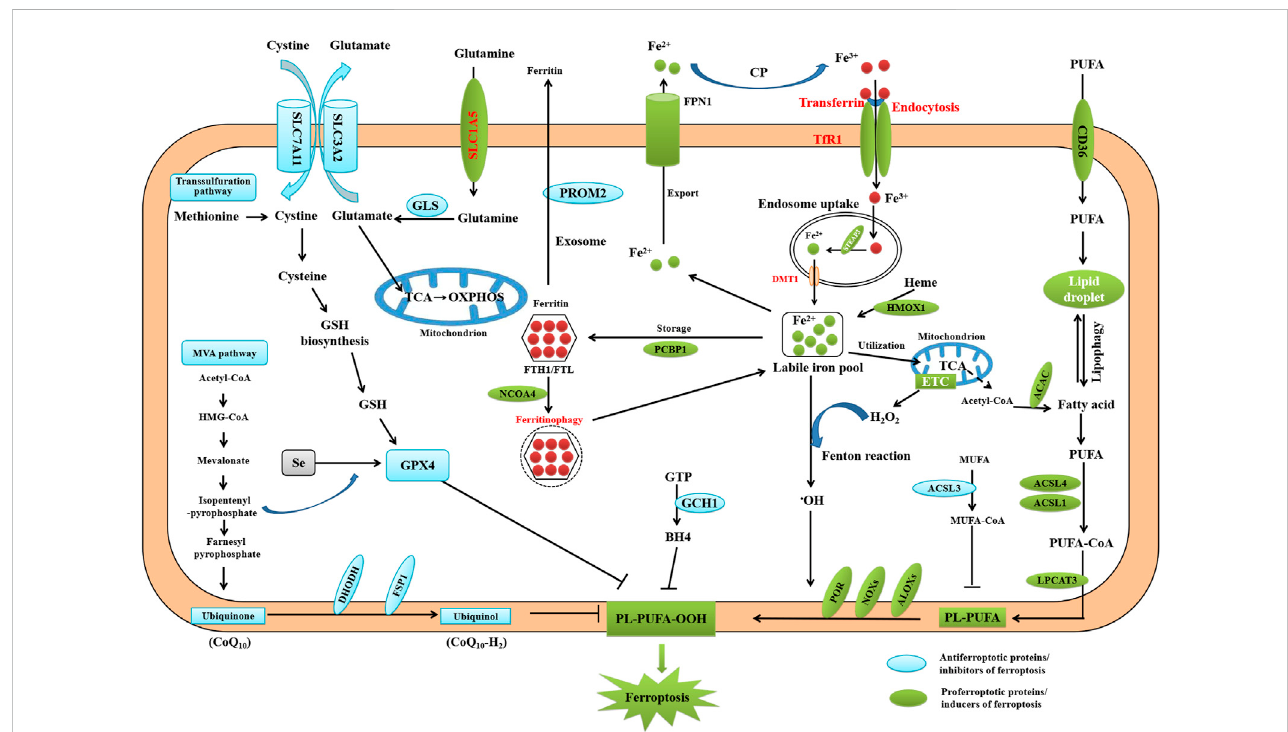
FIGURE 2 Core mechanismsofferroptosis. Ferroptosis is mainlycausedbyiron-dependentlipid peroxidation.The initiation of ferroptosis requires two keysignals, namely theaccumulationoffreeironandtheinhibitionofantioxidant SLC7A11/GPX4 system. Thegenerationofpolyunsaturated phospholipid (byACSL4 and LPCAT3) and subsequent activation of ALOX have a main role in promoting lipid peroxidation. This process requires HO from an iron-mediated Fenton reactionortheactivationofPOR,NOX,ormitochondriaelectrontransportchainpathways.Thelipidperoxidationoritssecondaryproducts(e.g.,4-HNE andMDA)induceporeformationinplasmaororganellemembrane,whicheventuallytriggerscelldeathatthe fi nalstepofferroptosis.Alternatively,CoQ10or tetrahydrobiopterin (BH4) inhibits ferroptosis independently of GSH. Importantly, all aspects of iron metabolism, including iron absorption, storage, export, and utilization, have an important regulatory effect on